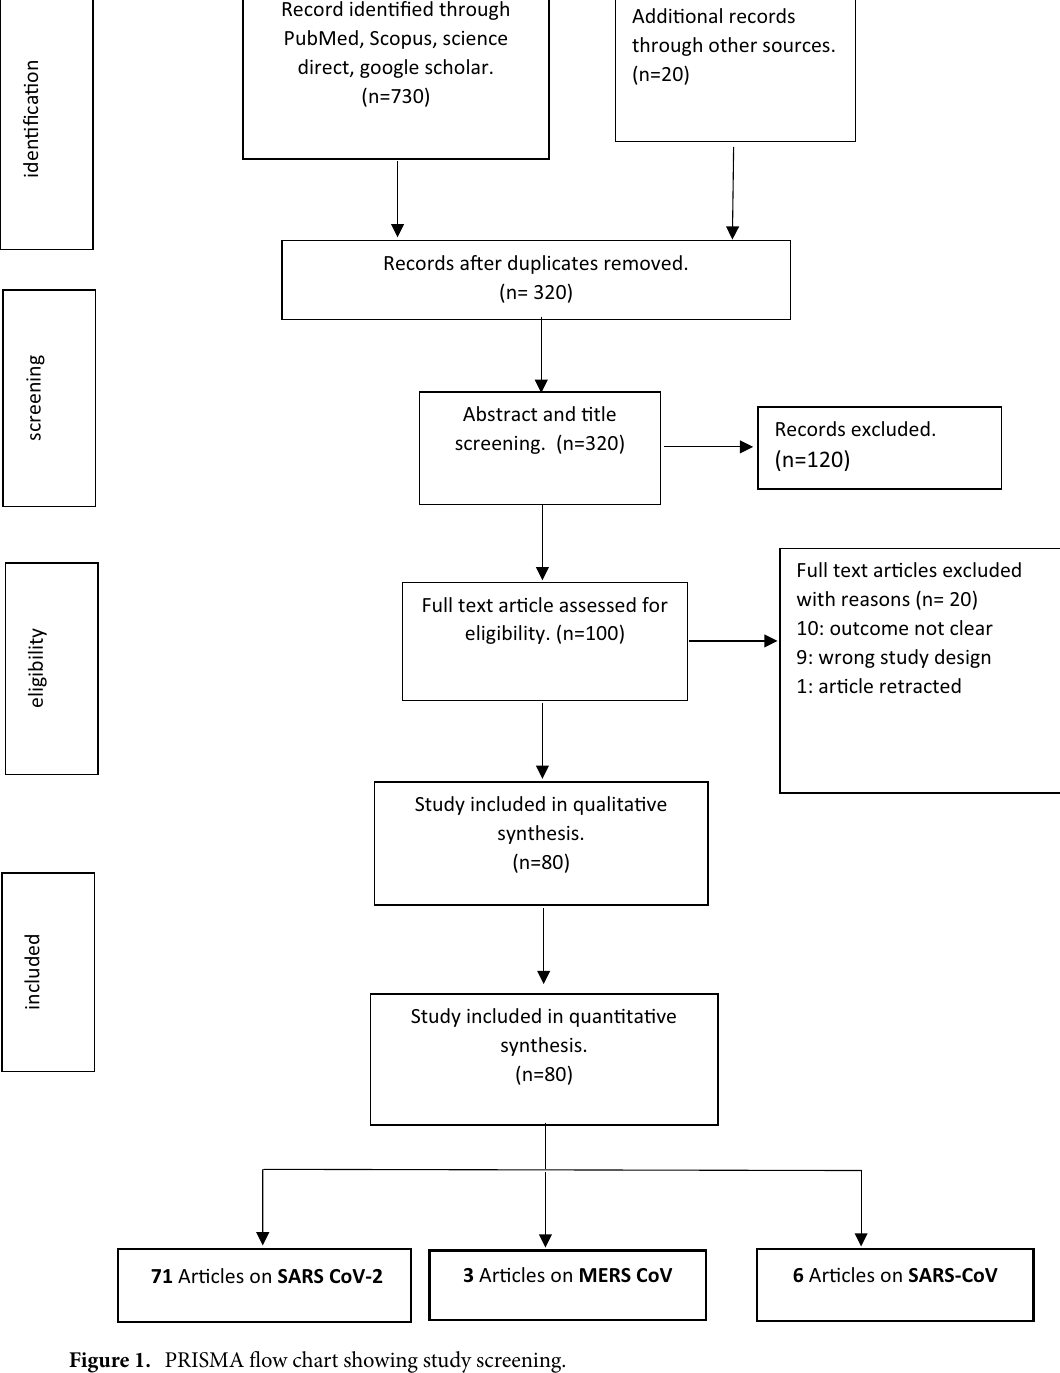
Figure 1. PRISMA flow chart showing study